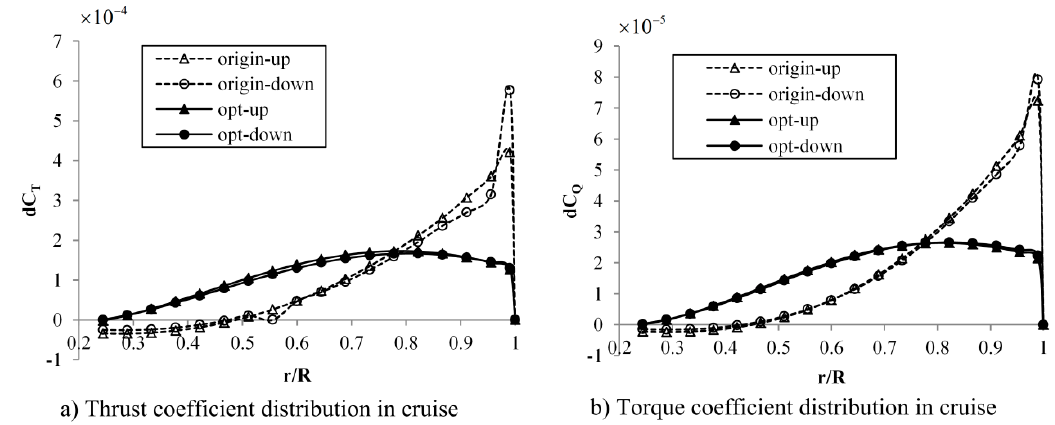
Figure 17. Spanwise load distribution on the upper and lower rotors of the optimized MTR in the hovering state.